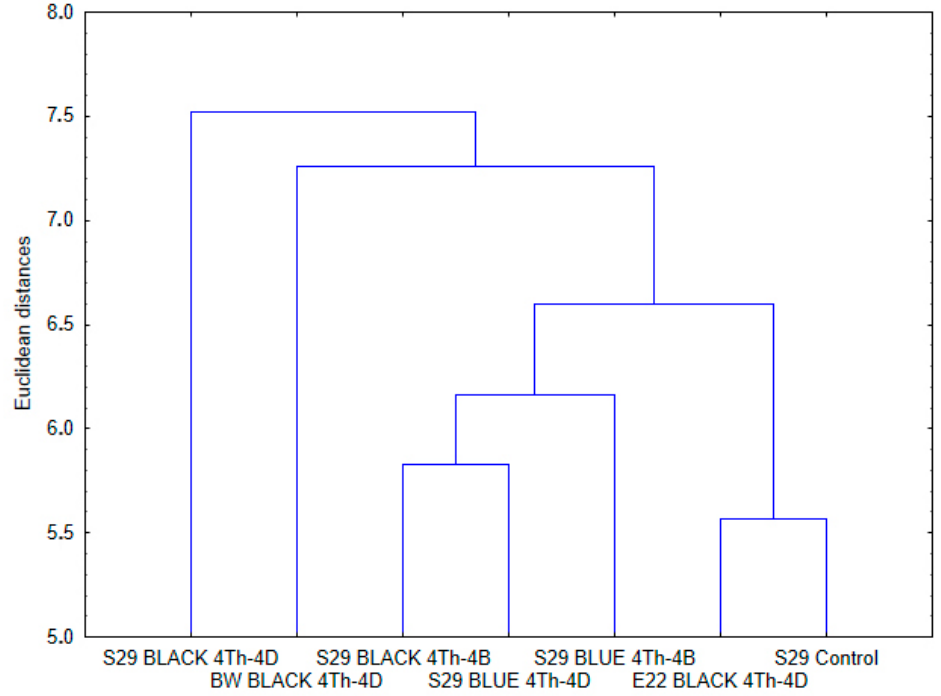
Figure 4. This tree was constructed by the unweighted pair group method with arithmetic mean (UPGMA) (based on Euclidean distances) from the data on 125 phenolic and nonphenolic substances of the seven T. aestivum lines.